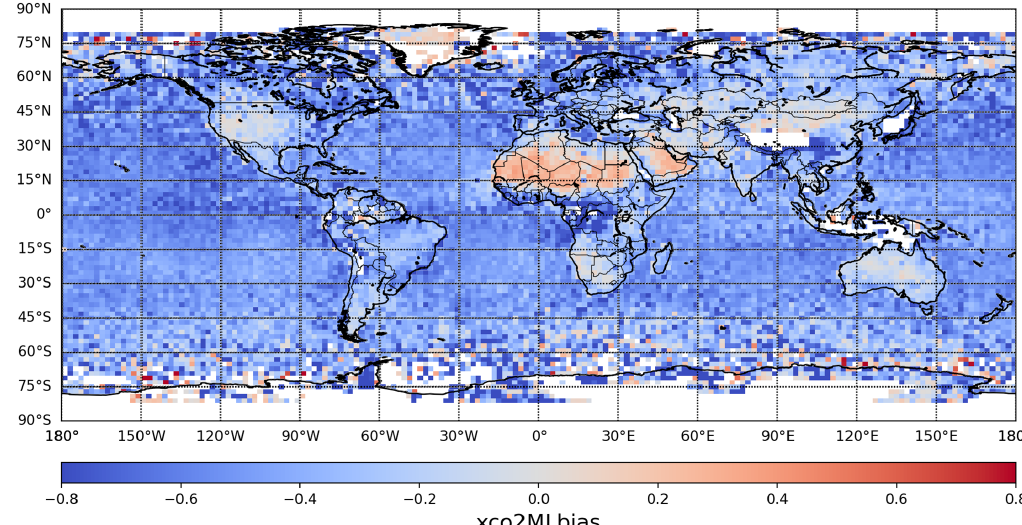
Figure 9. Biases in X CO identified by our model. Biases are averaged over 2 ◦ × 2 ◦ for all soundings (2014 to 2019; QF = 0 and QF = 1). 2 Negative biases are shown in blue, positive biases in red, and “no data” in white.